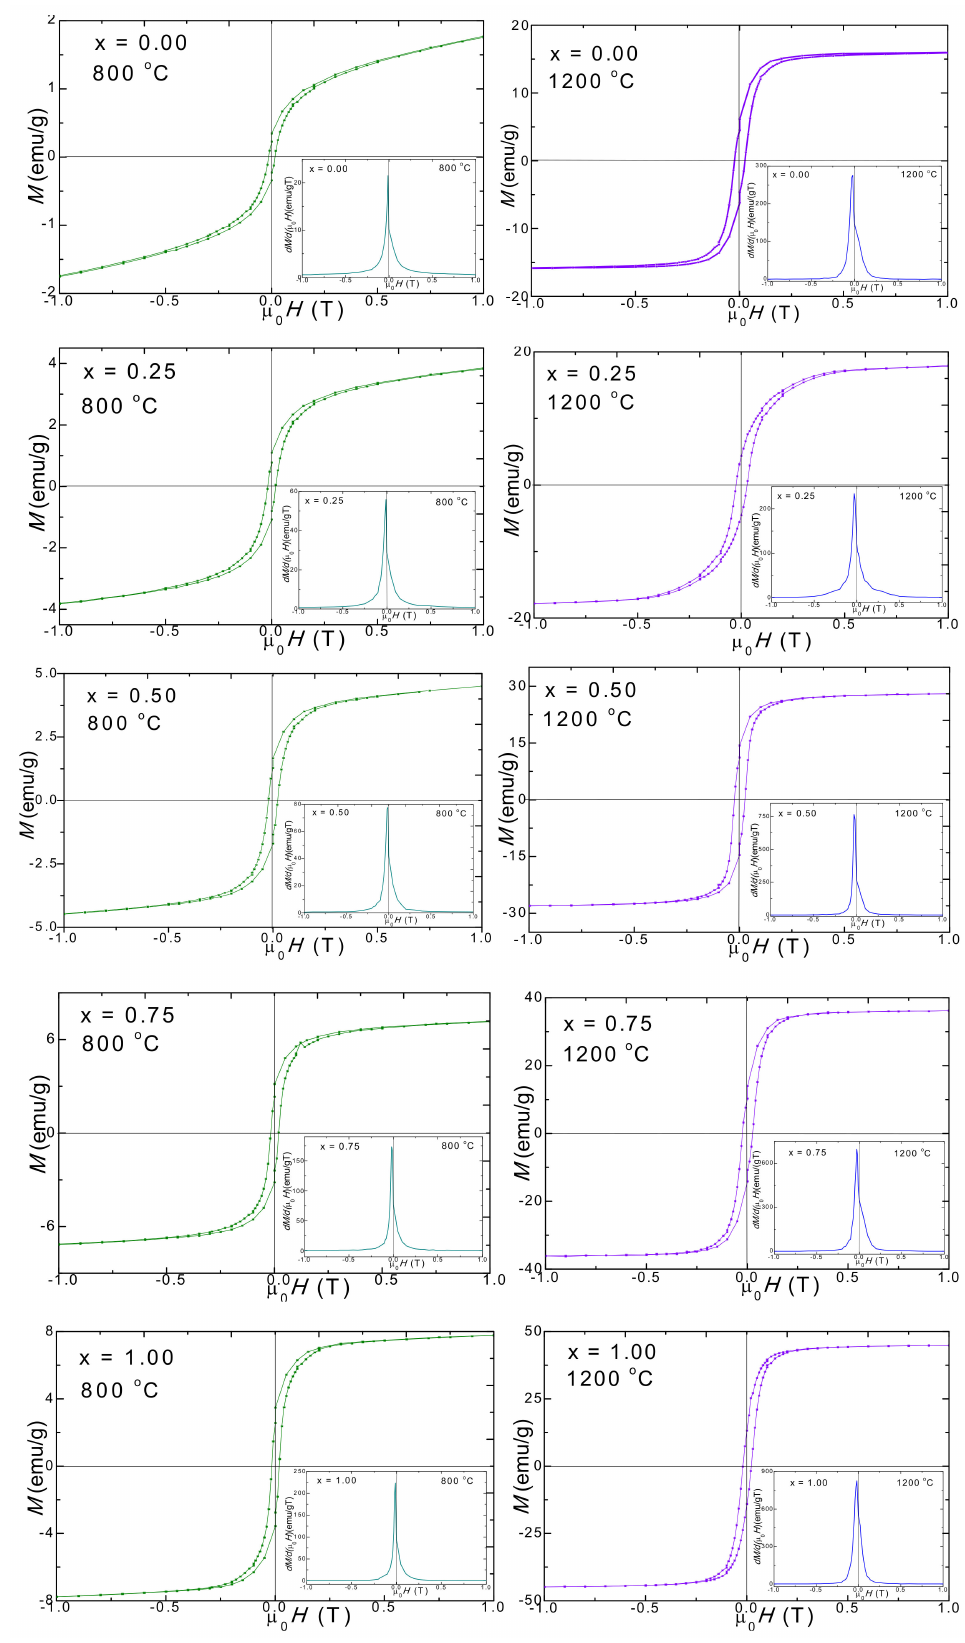
Figure 4. Magnetic hysteresis loops and magnetization derivative (in insets) for Mn 1 − x Ni x Fe 2 O 4 @SiO 2 NCs heat-treated at 800 and 1200 ◦